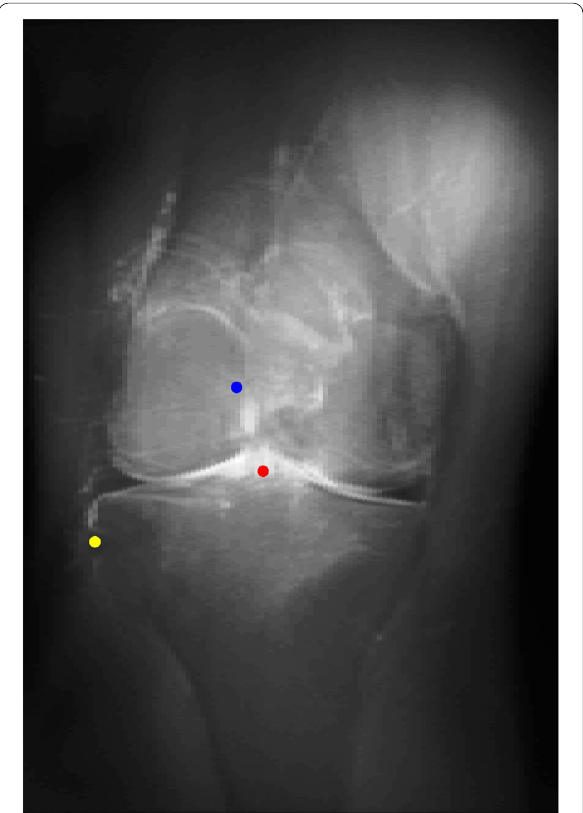
Fig. 4 AP conventional X‑ray Fig. 5 AP "CLASS" view (blue point: centroid ACL femoral footprint,